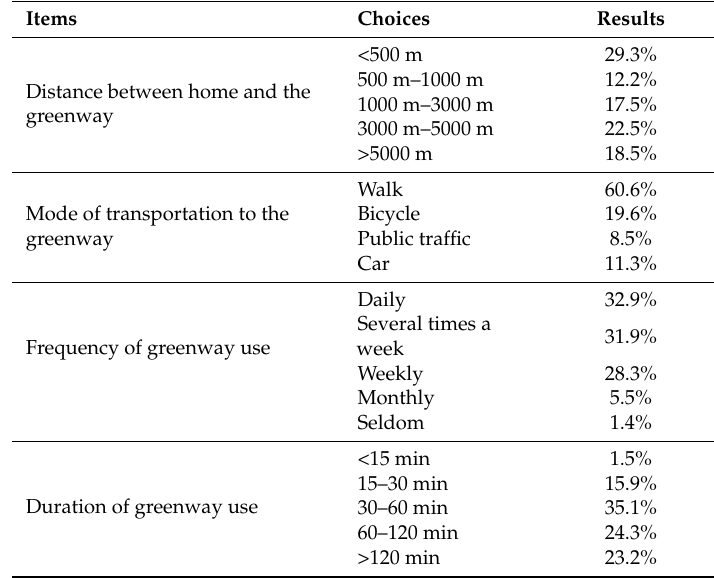
Table 2. Distance, transportation mode, frequency and duration of the